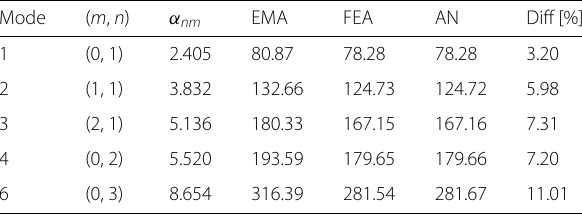
Table 4 Comparison of the natural frequencies [Hz] from experimental modal analysis (EMA), finite element analysis (FEA) and analytical (AN) analysis for λ = 1.0403 and R f = 80